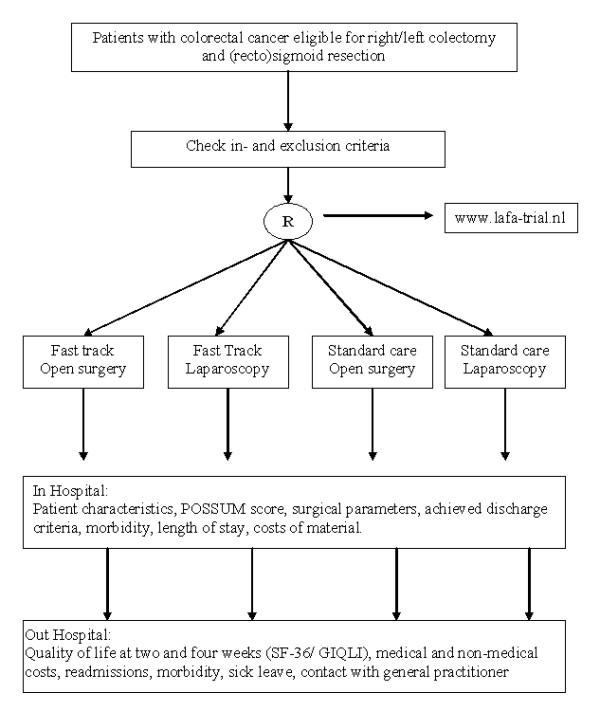
LAFA-study Flowchart. R = randomization, SF-36 = Short Form 36, GIQLI = Gastro-Intestinal Quality of Life Index, POSSUM score = Physiological and Operative Severity Score for the enUmeration of Mortality and Morbidity.